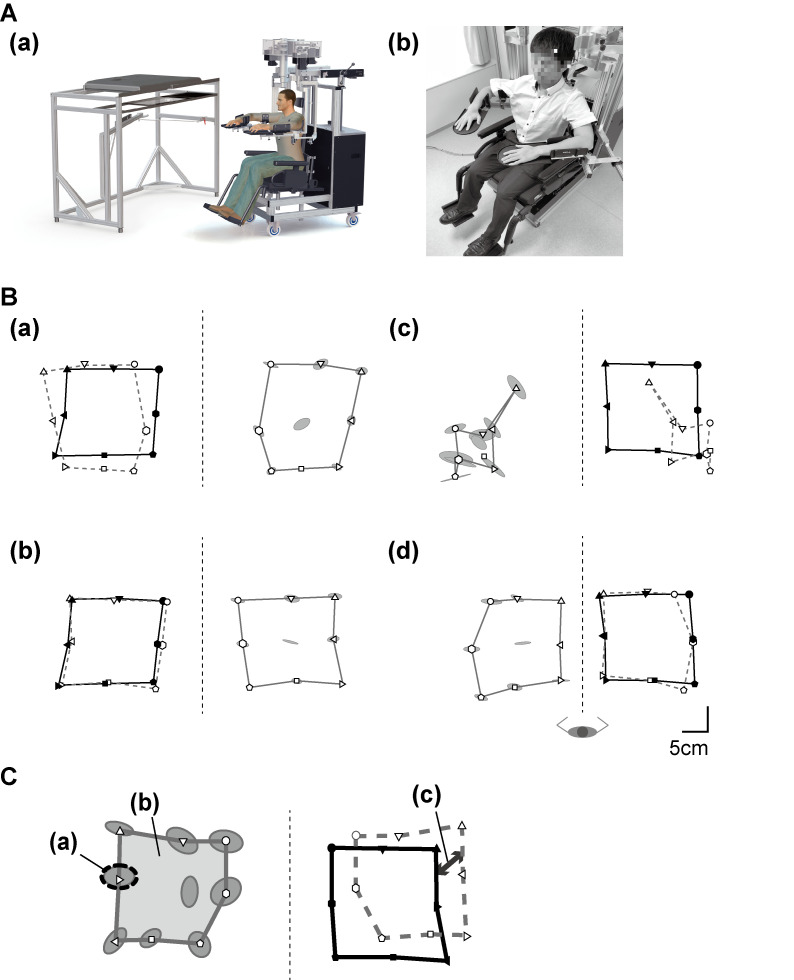
The KINARM Exoskeleton robotic device and measures of the arm position matching task.A. Overview of the robotic apparatus. (a) An overall cartoon depiction (courtesy of Kinarm Ltd., Kingston, Ontario). (b) Frontal view of the wheelchair base and exoskeleton arms. In performing the arm position matching task, the central target, which is the starting position, was set such that the shoulder was at approximately 30º of horizontal abduction and the elbow at 90º of flexion. B. Schema of the arm position matching task. Filled symbols (outlined with solid black lines) represent the positions where the robot moves the passive arm. Open symbols (outlined with solid gray lines) represent where the participants matched the perceived mirrored position with the active arm. The performance of the active arm is mirrored on the passive side using gray dashed lines. Ellipses around targets demonstrate variability of six matching attempts and represent one standard deviation. (a) A typical left-hemiparetic patient with the thumb localization test (TLT) score 0 displays little variability and is relatively accurate in matching the arm position with vision occluded. (b) In the same subject as (a), the matching is more accurate with vision restored. (c) A typical right-hemiparetic participant with the TLT score 3 shows increased variability, contraction of the workspace, and poor performance in overall matching with vision occluded. (d) In the same participant as (c), the accuracy of the matching is improved with vision restored. C. Illustration of the parameters. (a) Variability; trial-to-trial variability of the active hand, (b) Area; the overall spatial area matched by the active hand, (c) Shift; systematic shifts between the active and passive hands. The individual pictured in this figure has provided written informed consent (as outlined in PLOS consent form) to publish his image alongside the manuscript.